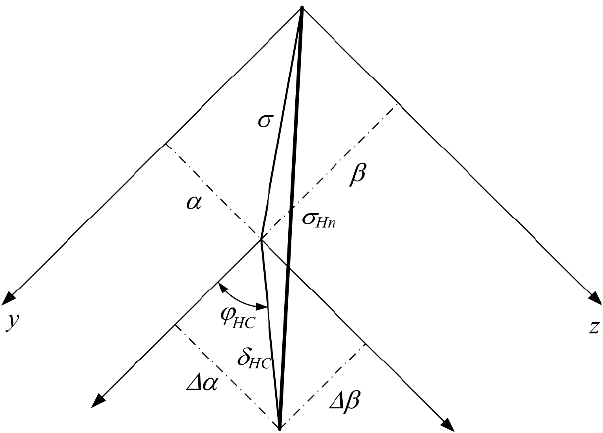
Figure 8. Angle σ Hn as the summation of total angle of attack σ and the error angle δ